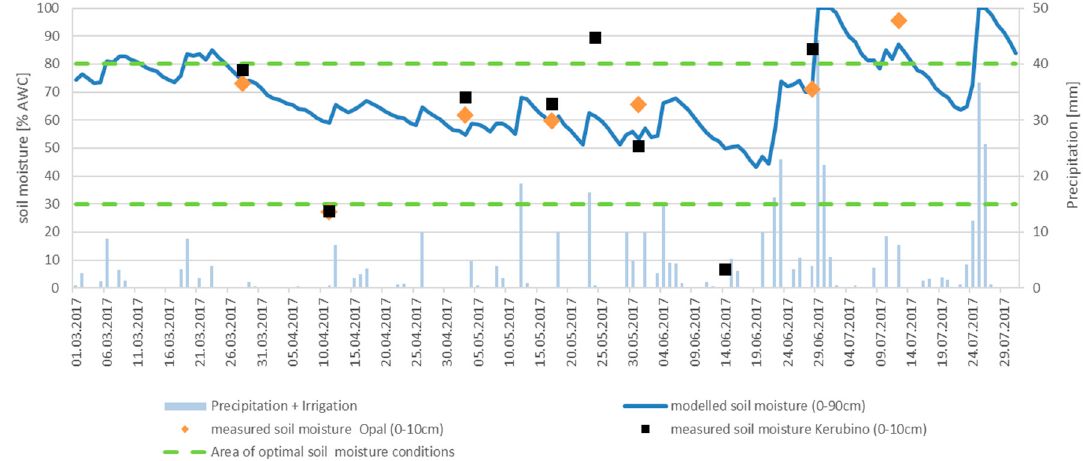
Figure 4. Modeled and measured soil moisture [% AWC] of t irrigated winter wheat plots Opal and Kerubino and precipitation [mm] in the period March to July 2017 .